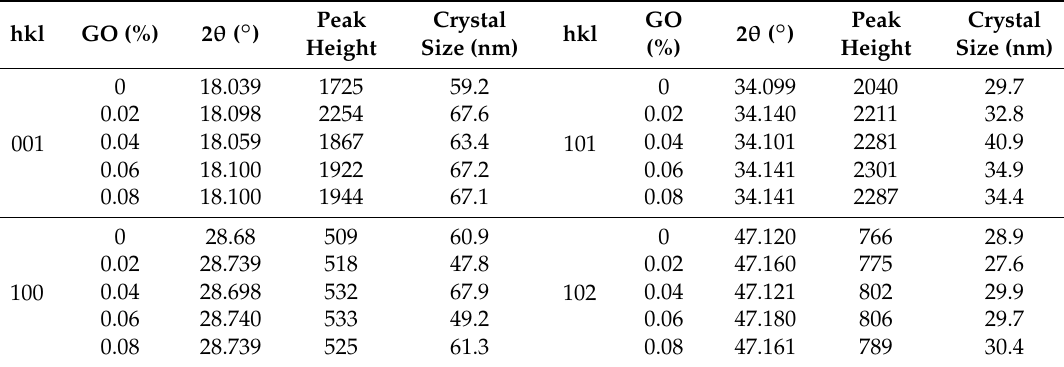
Table 3. CH diffraction peak intensity and crystal size at 28